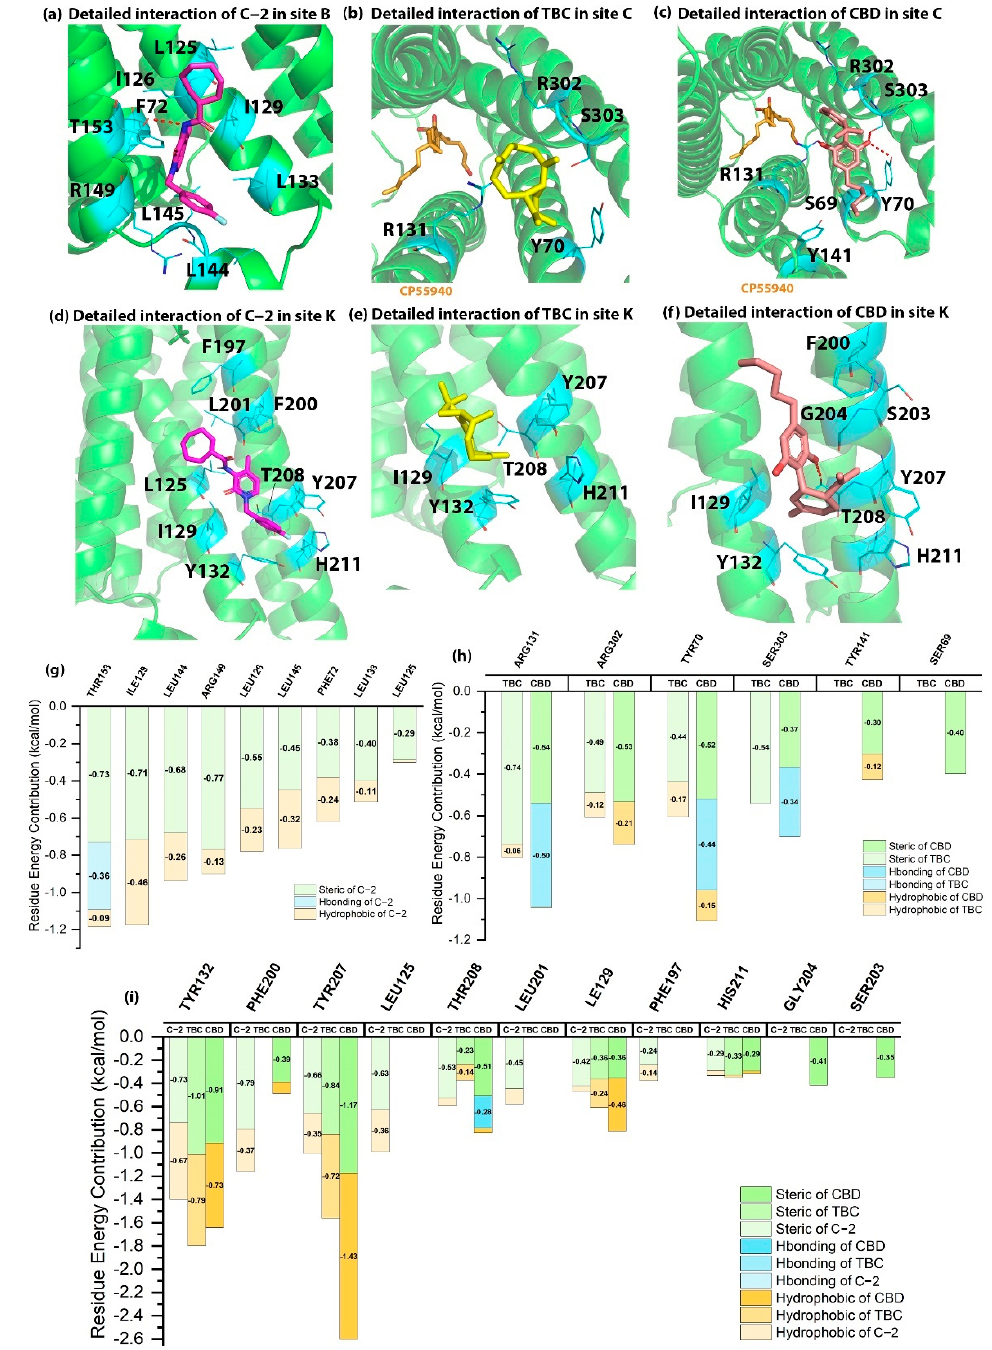
Figure 2. The detailed interactions and residue energy contribution of C-2, TBC and CBD in sites B, C and K. ( a ) The detailed binding pose of C-2 in site B. ( b ) The detailed binding pose of TBC in site C. ( c ) The detailed binding pose of CBD in site C. ( d ) The detailed binding pose of C-2 in site K. ( e ) The detailed binding pose of TBC in site K. ( f ) The detailed binding pose of CBD in site K. ( g ) The residue energy contribution of key residues for C-2 in site B. ( h ) The comparisons of residue